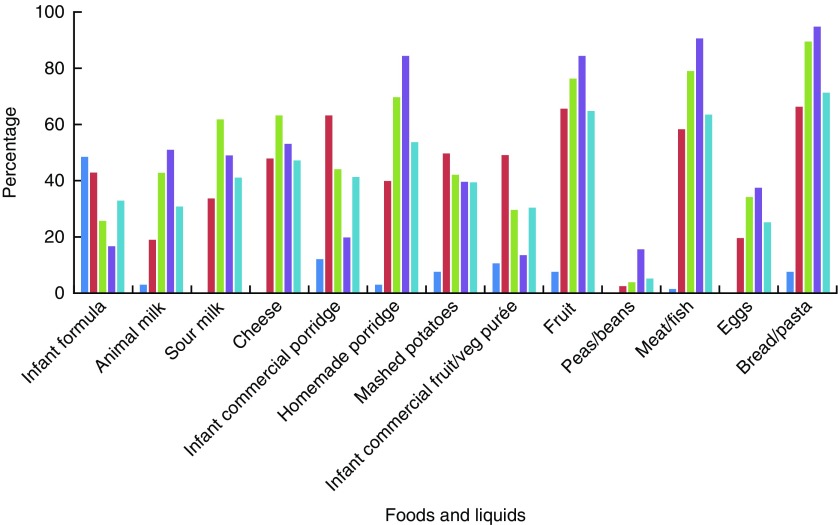
(colour online) Proportion given foods and liquids in the 24 h preceding the survey, by age group (, 0–5 months; , 6–11 months; , 12–17 months; , 18–23 months; , total), among internally displaced children aged <2 years residing in Kharkiv, Dnipropetrovsk and Zaporizhia oblasts, eastern Ukraine, June 2015